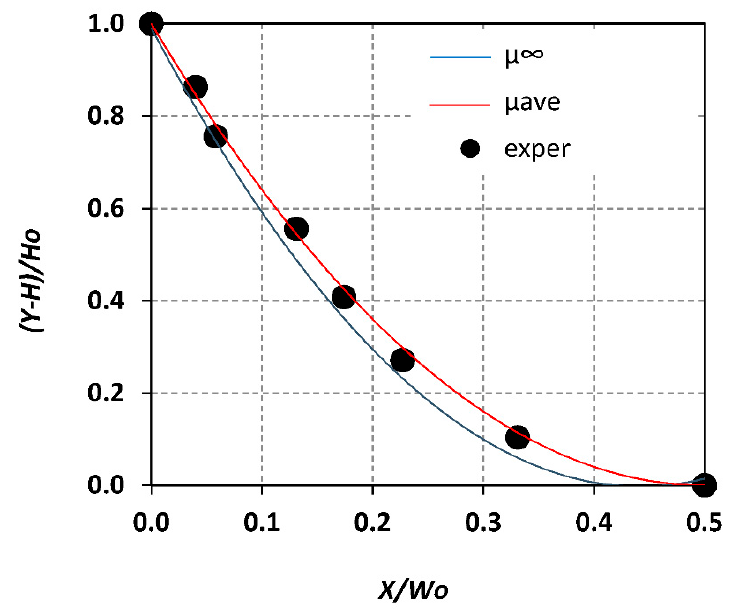
Figure 11. Comparison between experimental and estimated local meniscus height.